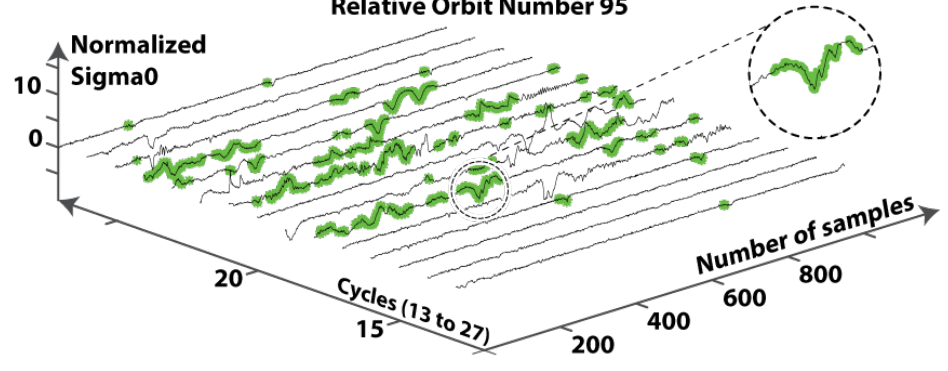
Figure 6. Graphic representation of a sequence of 15 cycles for relative orbit number 95 of Sentinel-3A (SRAL sigma0) for a stretch over more than 300 km off the Amazon shelf in the tropical Atlantic Ocean. The green segments indicate detection of ISWs by the algorithm developed in this paper.